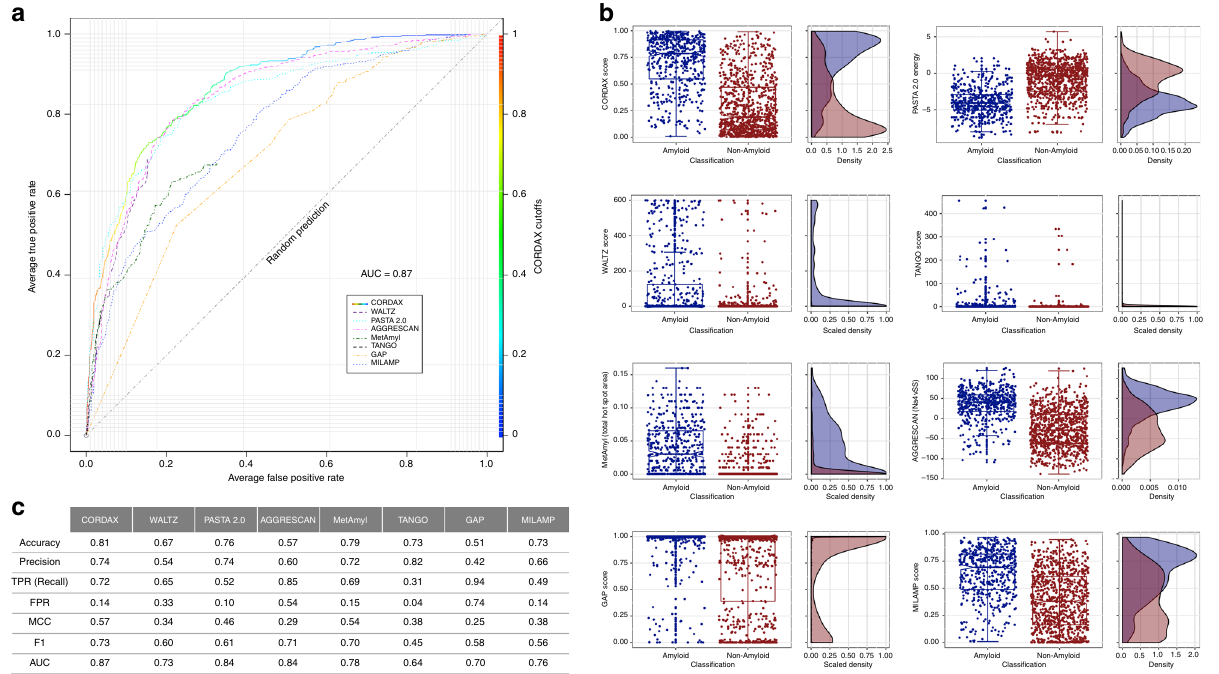
Fig. 3 Benchmarking of CORDAX. a ROC curve analysis for Cordax and seven other state-of-art methods against WALTZ-DB 2.0. For WALTZ, TANGO and MetAmyl, FPR stops at earlier rates due to minimal scoring variations. b Cordax score distribution compared to other tools. The regression model achieves better scoring separation for predictions between amyloid-forming (shown in blue) and non-amyloid sequences (shown in red). Distributions are shown as standard box-plots highlighting median, upper (Q3) and lower (Q1) quartiles. Whiskers indicate the ranges for values within 1.5 interquartile range (IQR) above and below Q3 and Q1, respectively. Density plots for WALTZ, TANGO, MetAmyl and GAP are scaled due to the overrepresentation of unscored values or false positives, respectively. c Performance metrics comparison indicating Cordax superiority to other sequence predictors (MCC = 0.57, F1 = 0.73 and AUC =